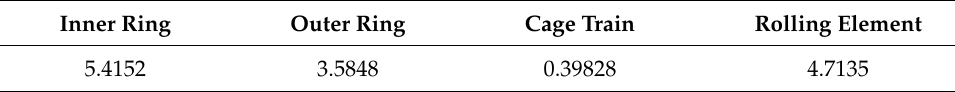
Table 3. Failure frequency of key